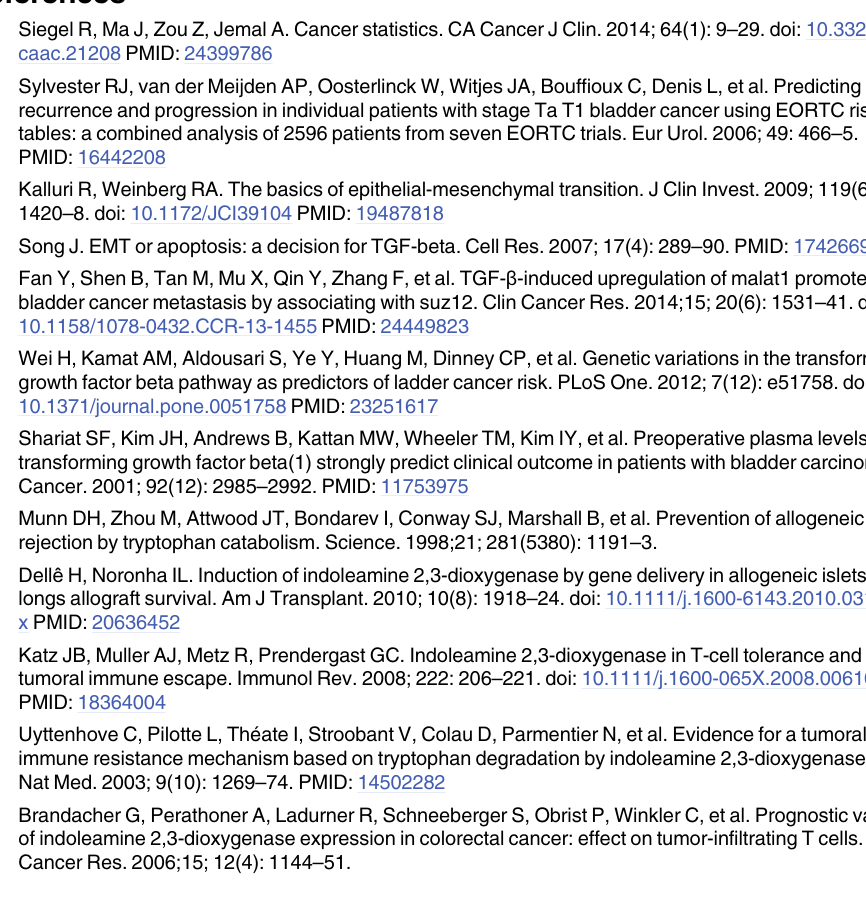
S1 Fig. Histology of the renal tissue after subcapsular inoculation of T24 cells. To analyze T24 cell invasion in vivo , we inoculated 1X10 6 cells under the kidney capsule. Histology (hema- toxylin and eosin staining) was assessed 28 days after inoculation. (A) T24 cells under the kid- ney capsule (arrowhead), and (B) T24 cells infiltrating the renal parenchyma toward the renal medulla (arrow). Renal parenchyma is indicated with asterisk.